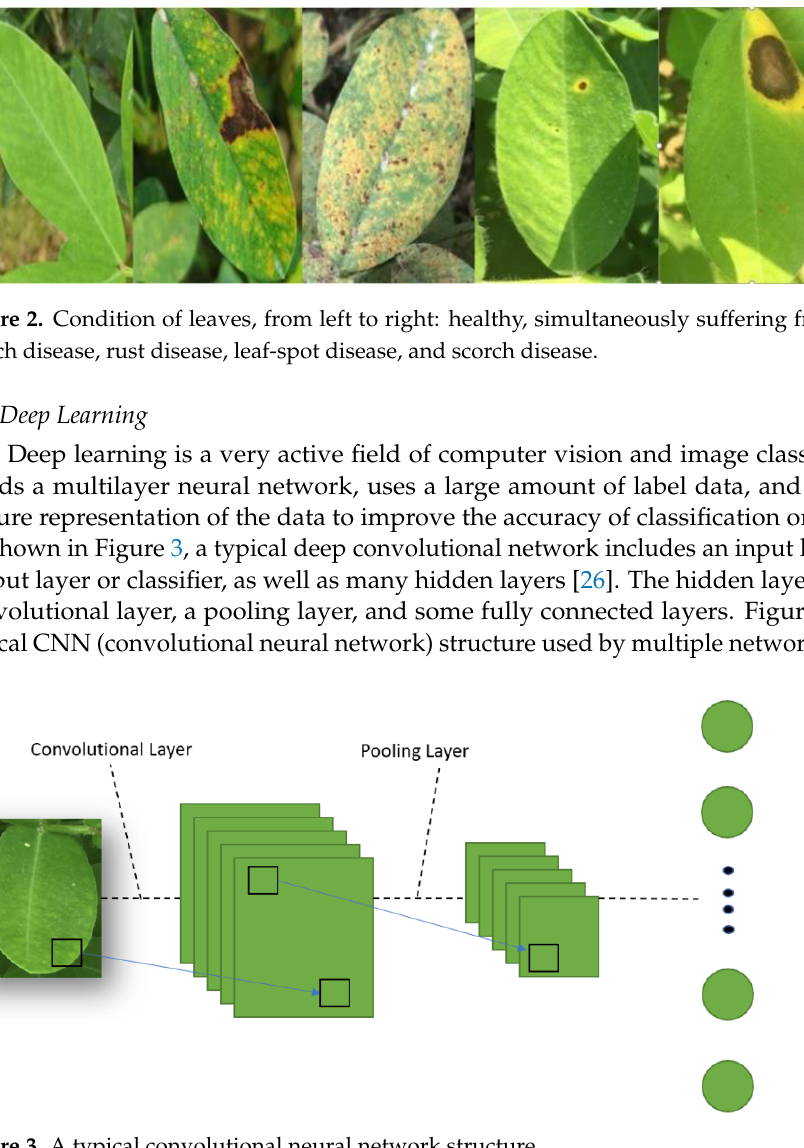
Figure 3. A typical convolutional neural network